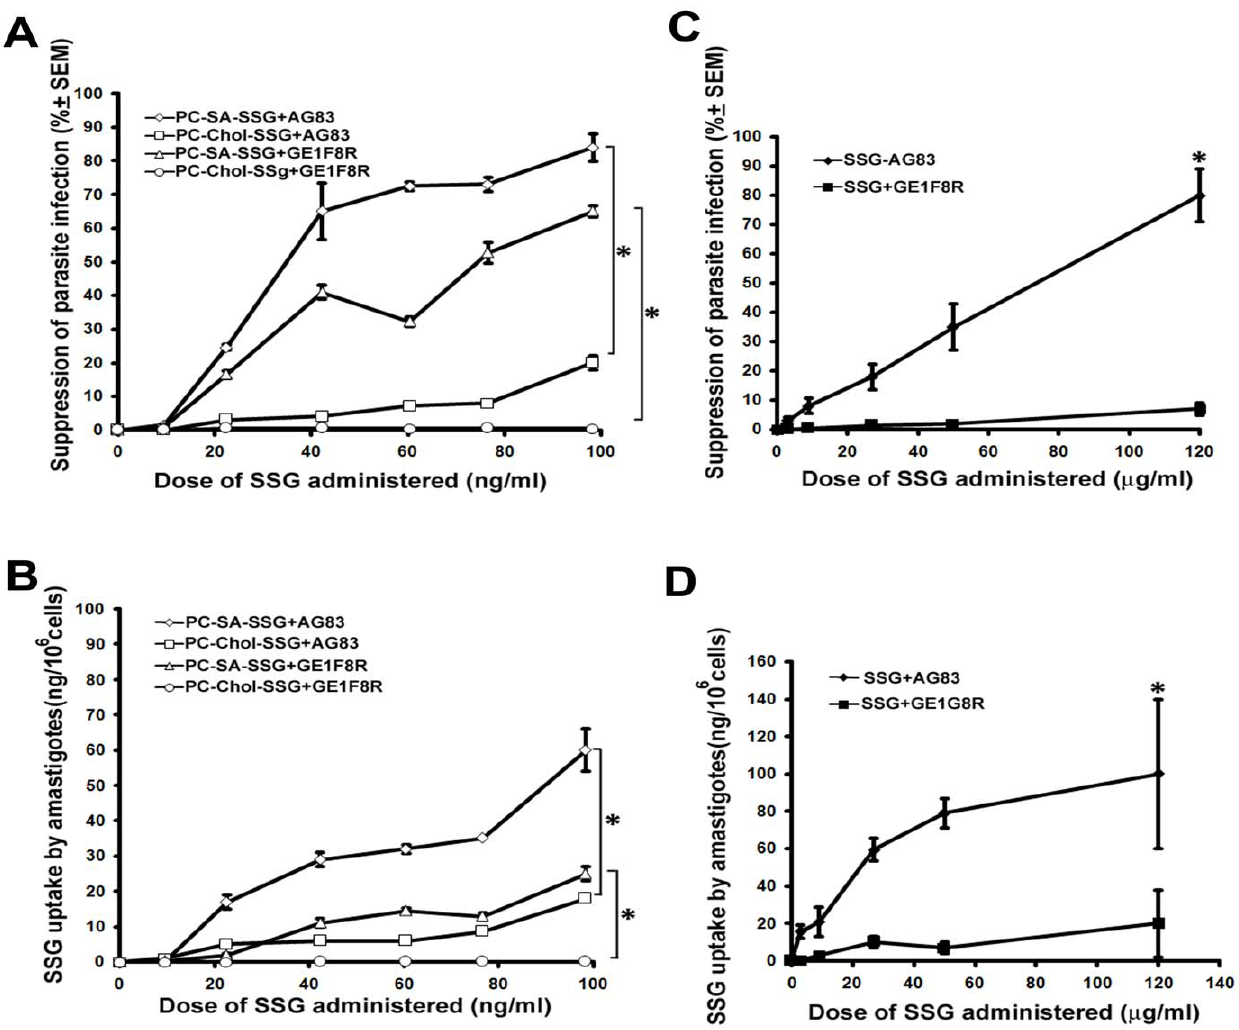
Figure 3. Parasite suppression in Ldonovani -infected macrophages and SSG accumulation in intramacrophagic amastigotes. Both AG83 and GE1F8R infected peritoneal macrophages were treated with (A, B) PC-SA-SSG, PC-Chol-SSG, and (C, D) free SSG for 72 h. (A, B) The treatment-induced percentage suppression of parasites was calculated in comparison to respective untreated-control. (B, D) Total SSG uptake by intramacrophagic amastigotes following various treatments was estimated by atomic absorption spectroscopy (AAS), and represented as nanogram (ng)/10 6 cells. Data represent the mean 6 SEM of three independent experiments. * p , 0.05 compared to AG83 and GE1F8R strains treated with PC- Chol-SSG.